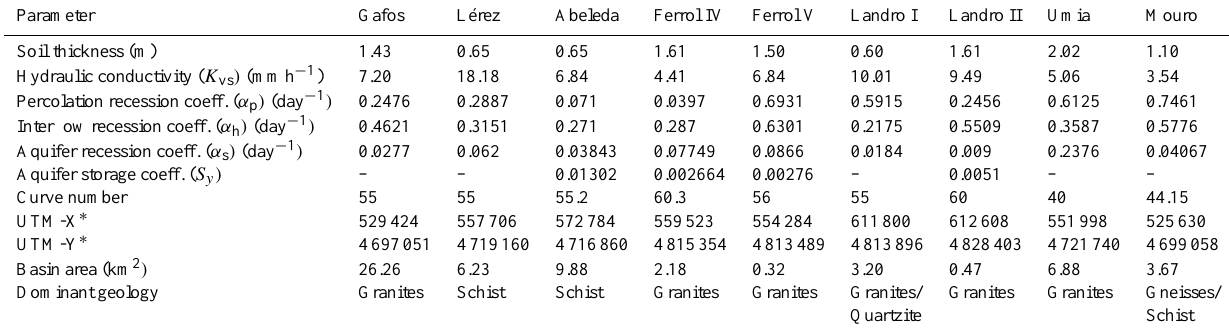
∗ Projected Coordinate System: WGS 1984 UTM, Zone 29 ◦ N.